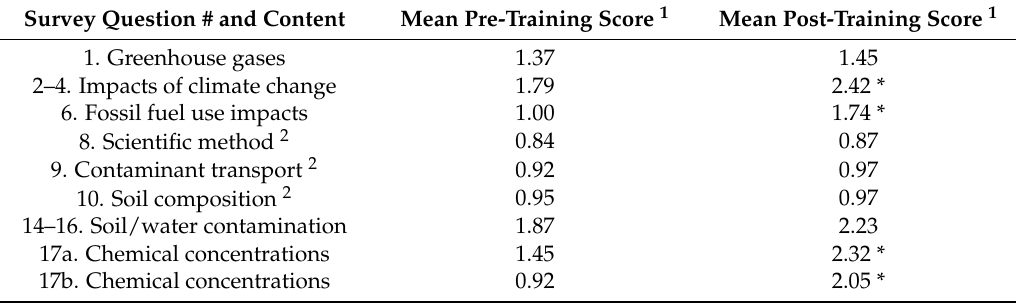
Table 5. Level of environmental science knowledge pre- and post-training, all